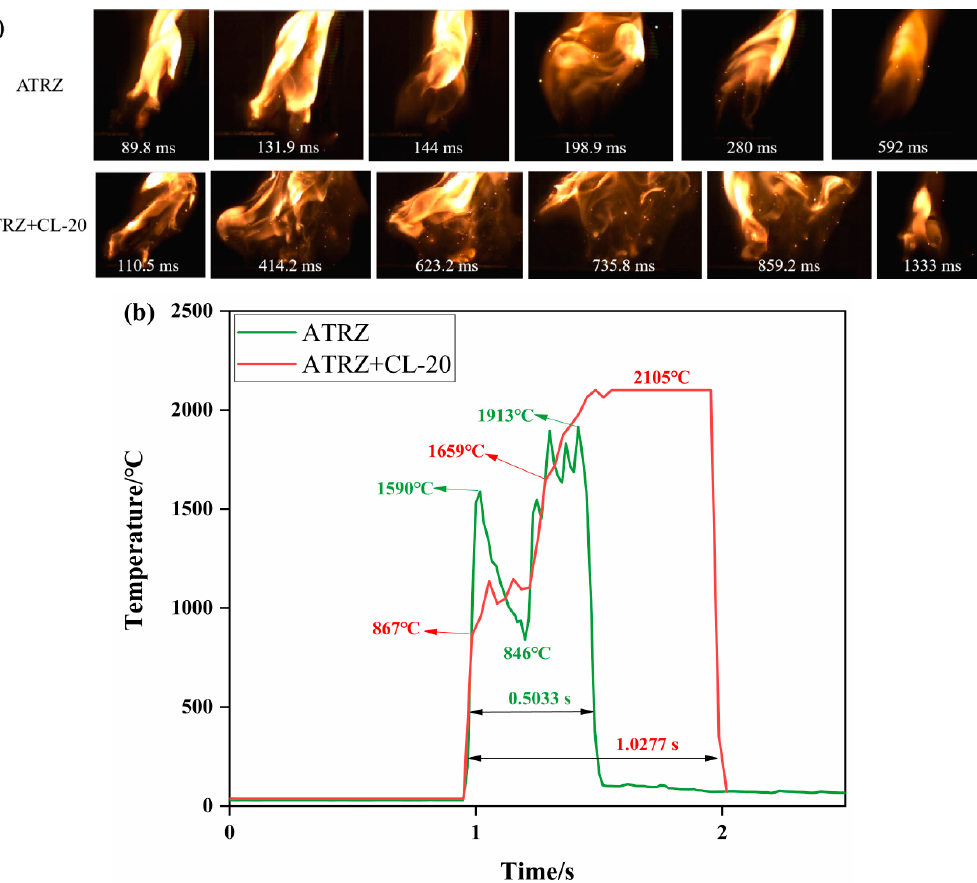
Figure 12. Combustion behaviors of ATRZ and ATRZ+CL-20 ( a ) and temperature evolution curves ( b ).